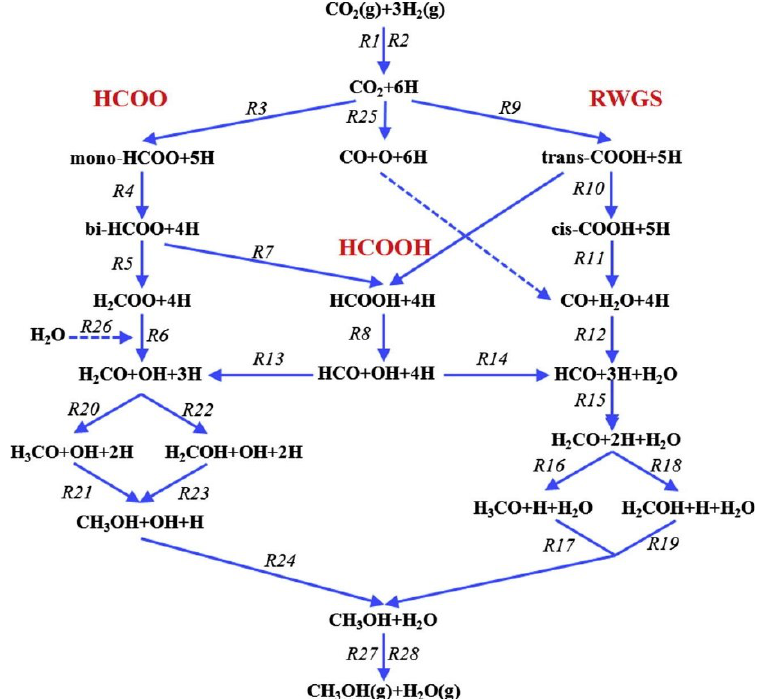
Figure 6. Three possible pathways of CO 2 hydrogenation. Reprinted with permission from [65].